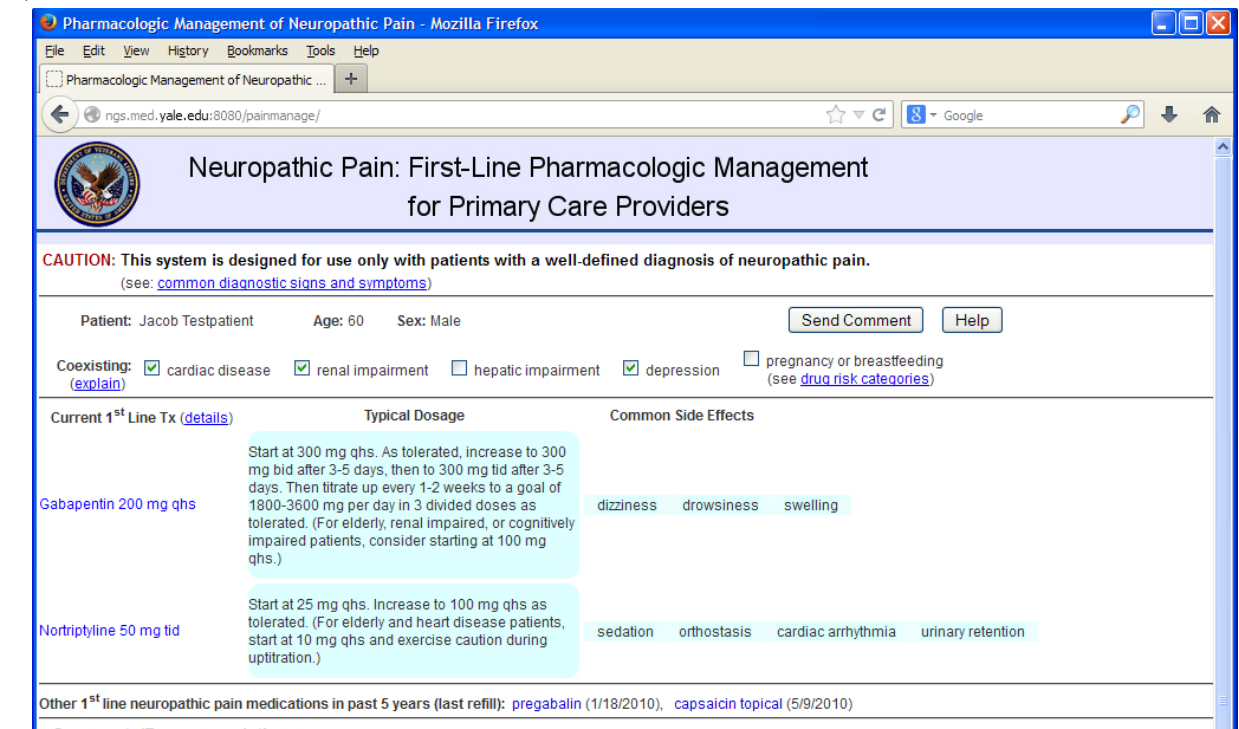
Figure 1. The Web-based clinical interface of Neuropath/CDS, as described in the text. TCA=tricyclic antidepressant, SNRI=serotonin–norepinephrine reuptake